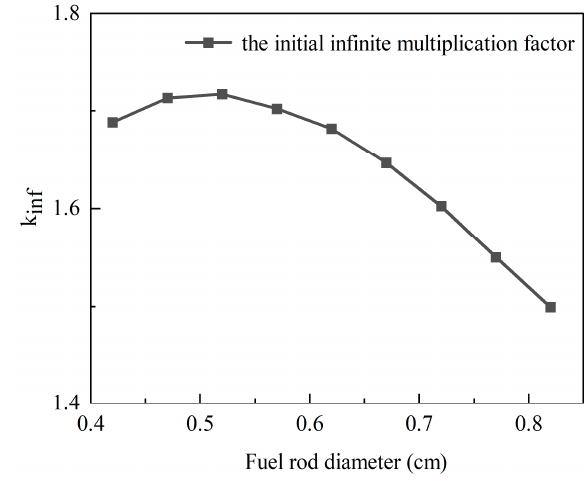
Figure 9. Variation in k inf (BOL) with fuel rod diameter.